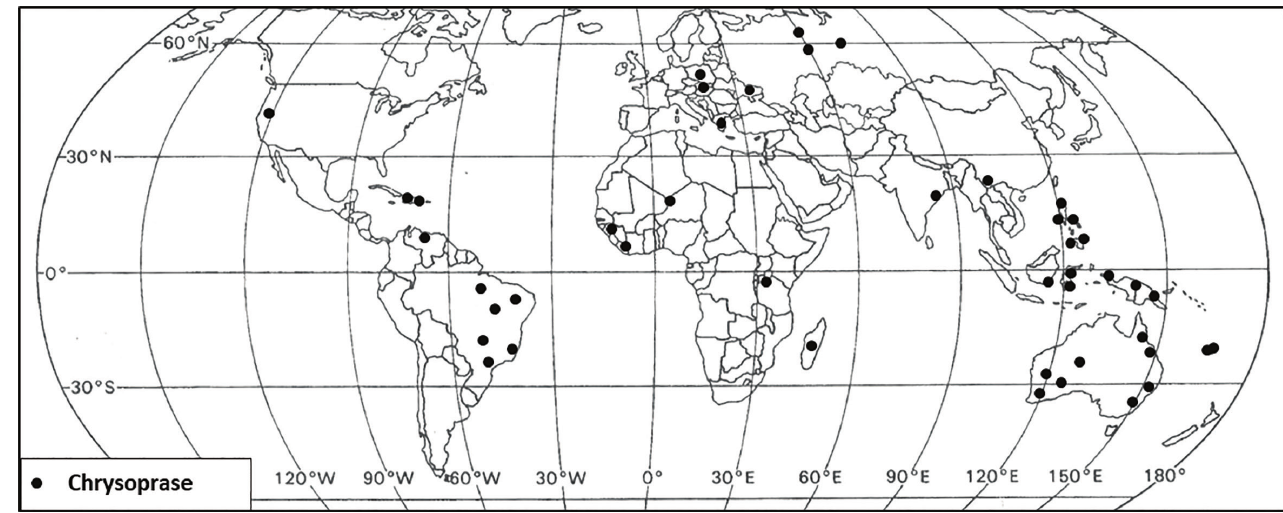
Figure 3. Map of chrysoprase occurrences in the world. Prepared by M.